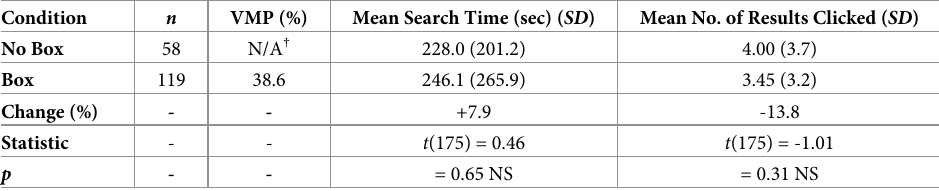
Table 3. Experiment 2: VMP, search times, and results clicked by